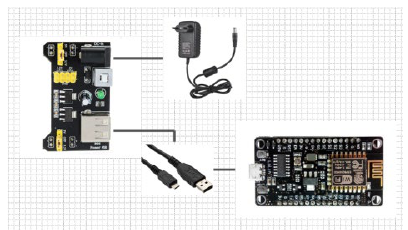
Figure 4. Planning Breadboard Power Supply